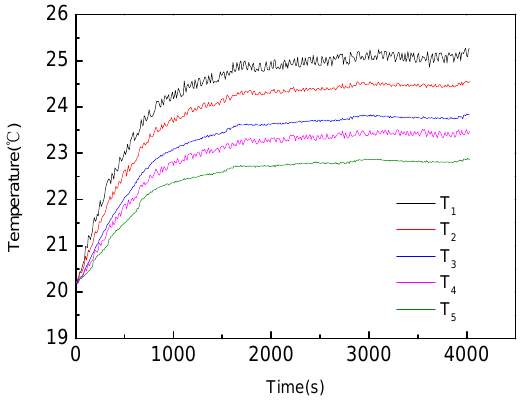
Figure 5. The temperature variation of the composite for the porosity of 95%. Fig ure 5. The temperature variation of the composite for the porosity of 95%.